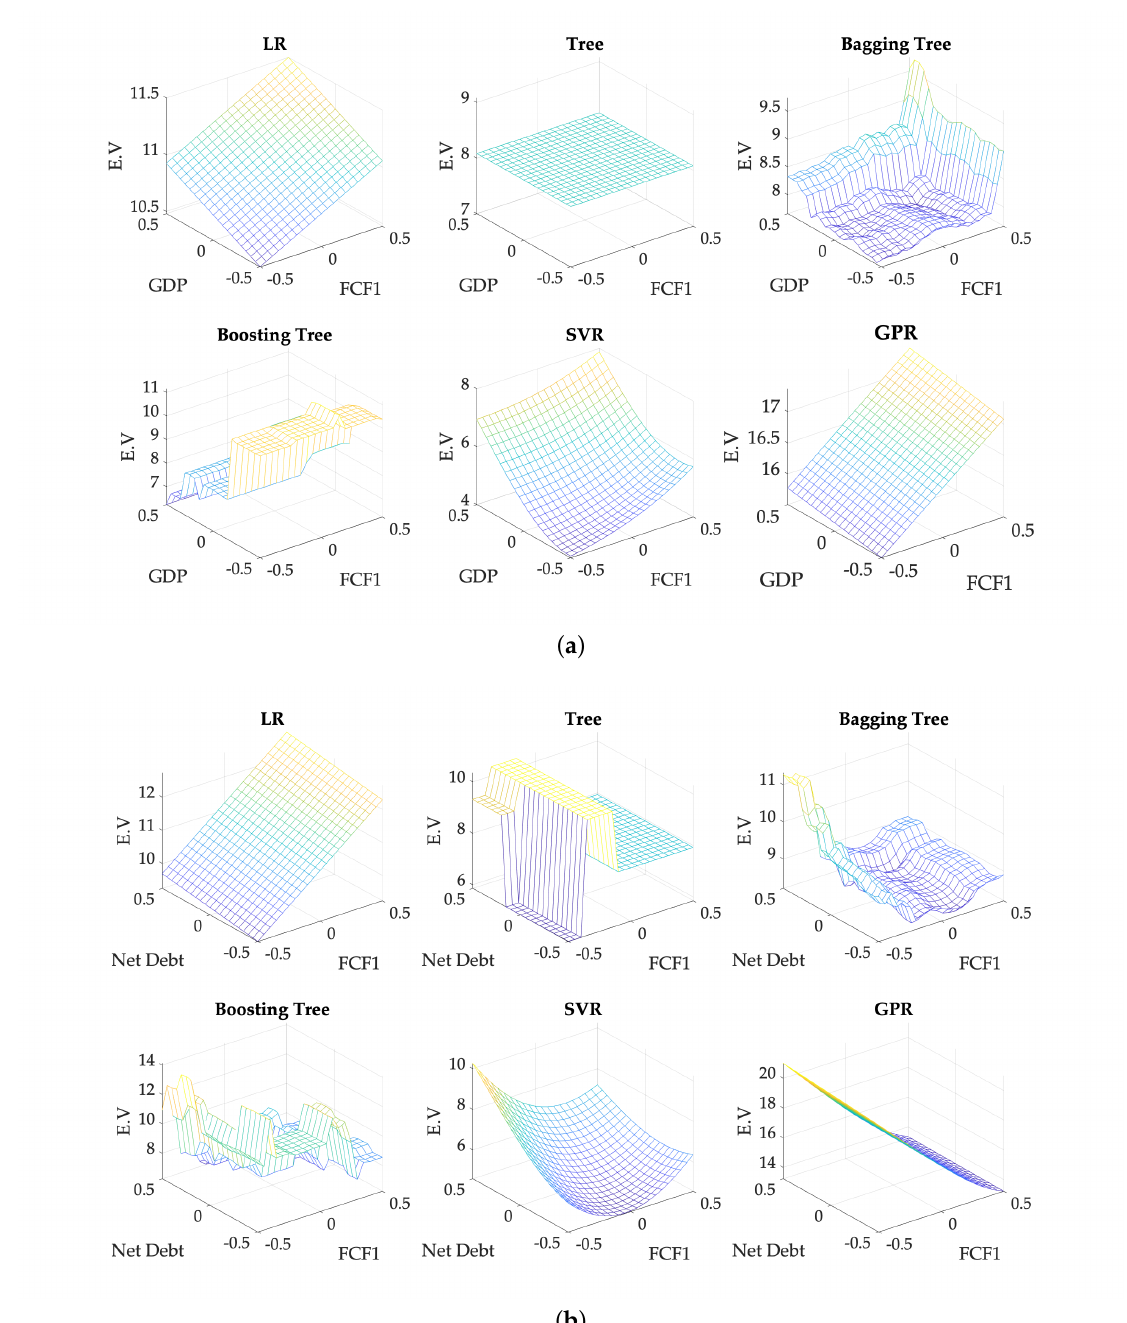
Figure 4. Paired trend analysis of significant variables: ( a ) FCF & Deb Net; ( b ) FCF &